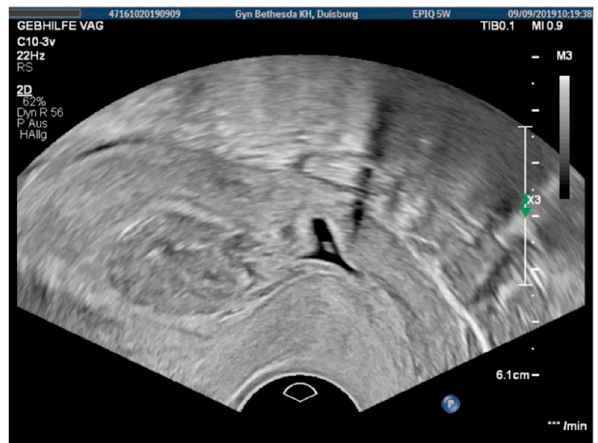
Figure 2. Transvaginal ultrasound showing a niche pregnancy with 6 weeks of gestation.